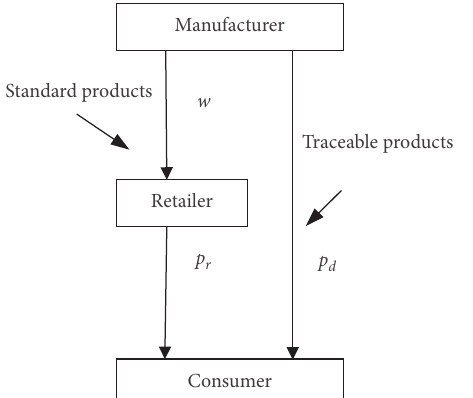
Figure 1: Dual-channel supply chain model for online traceable